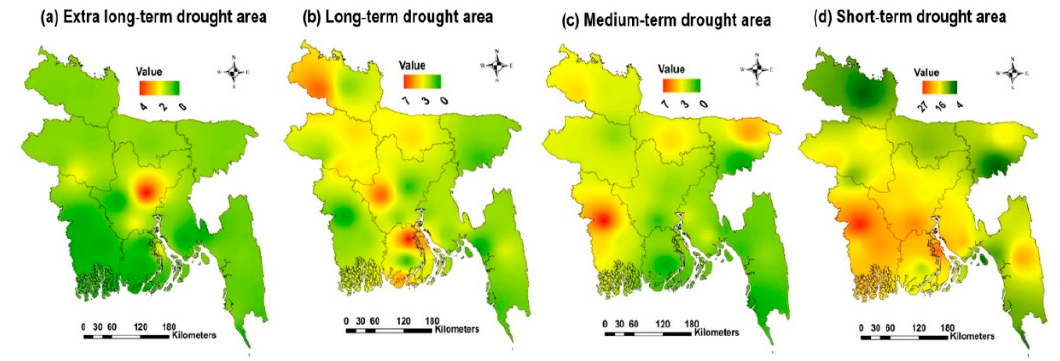
Figure 7. Spatial pattern of drought events during 1981–2015: ( a ) Extra long-term; ( b ) Long-term; ( c ) Medium-term; ( d ) Short-term drought duration.